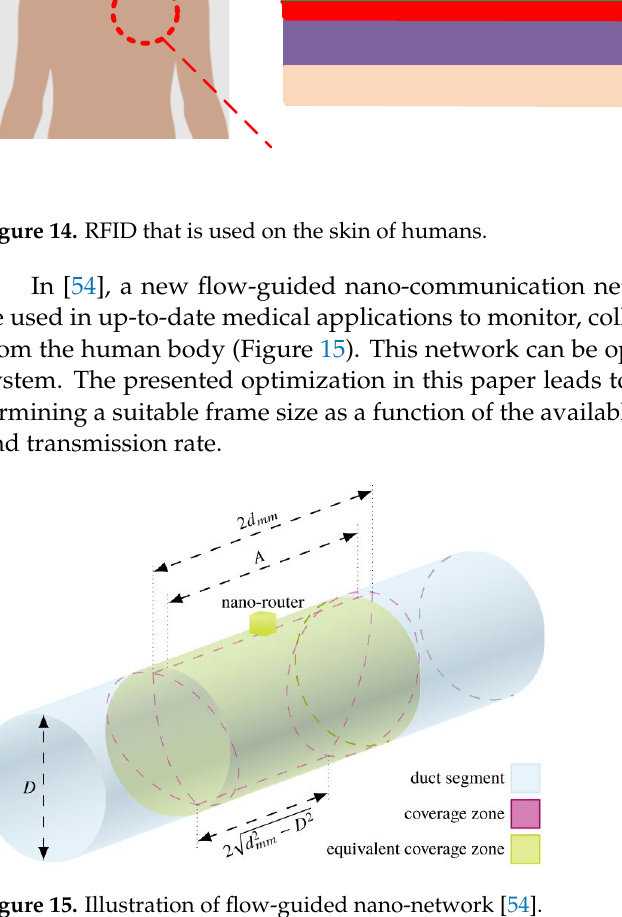
Figure 15. Illustration of flow-guided nano-network